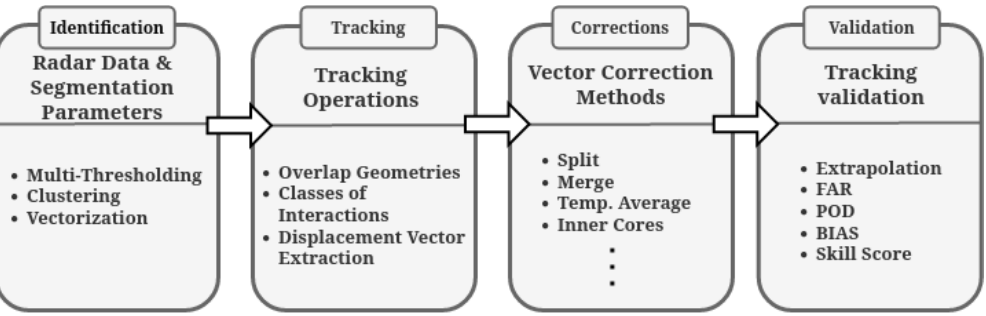
Figure 2. Flowchart of the method applied for tracking and validation of the precipitating